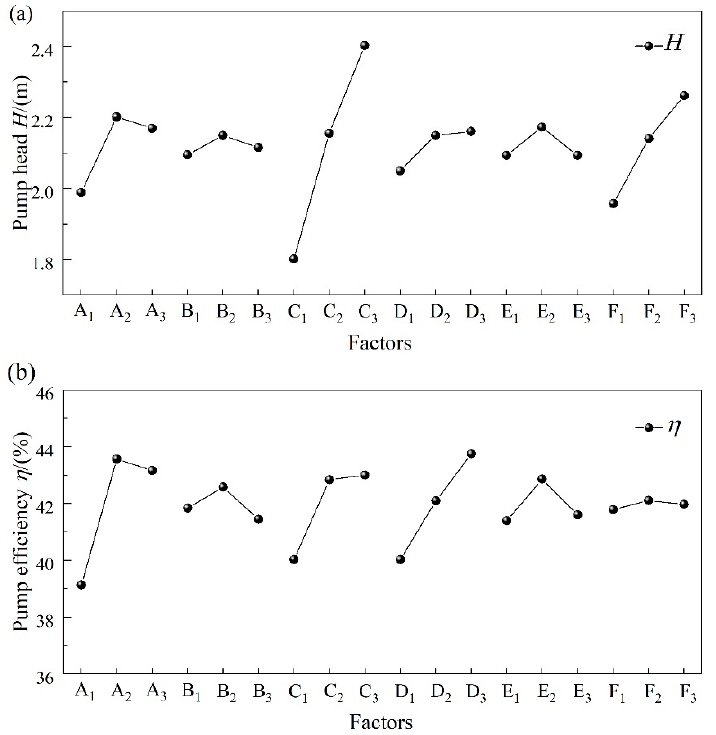
Figure 8. Relationship between factors and performance indicators: ( a ) pump head and ( b ) pump efficiency.